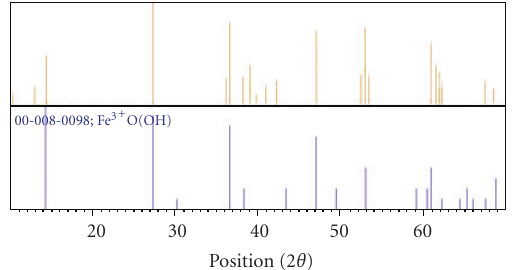
Figure 16: XRD peak di ff racted pattern seen in Figure